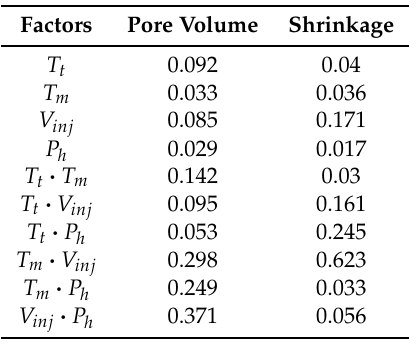
Table 5. Results of the ANOVA ( p -value) considering the DOE plan.